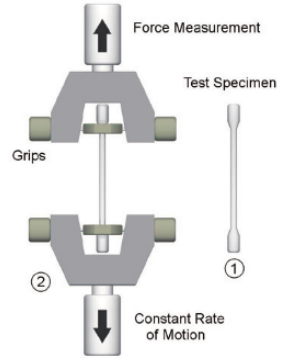
Figure 6. Tensile Strength test [32].